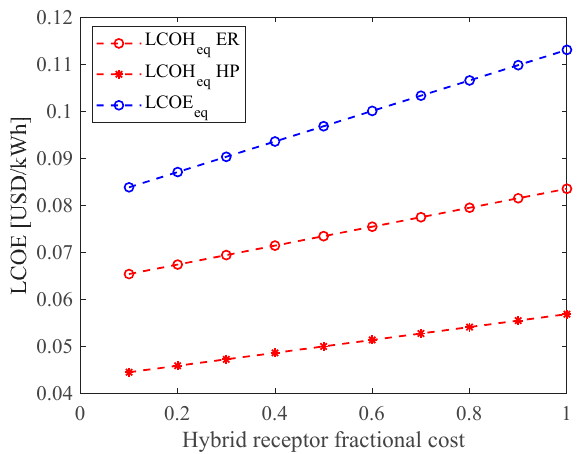
Figure 9. Levelized cost of electricity (LCOE) and levelized cost of heat (LCOH) as a function of the hybrid RFC (Source: Author’s own